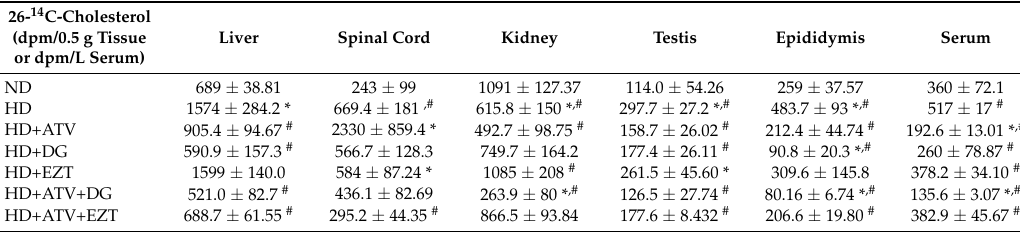
Table 2. Body distribution of 26- 14 C-cholesterol in rats with a cholesterol-rich diet that received DG, ATV, EZT, or their